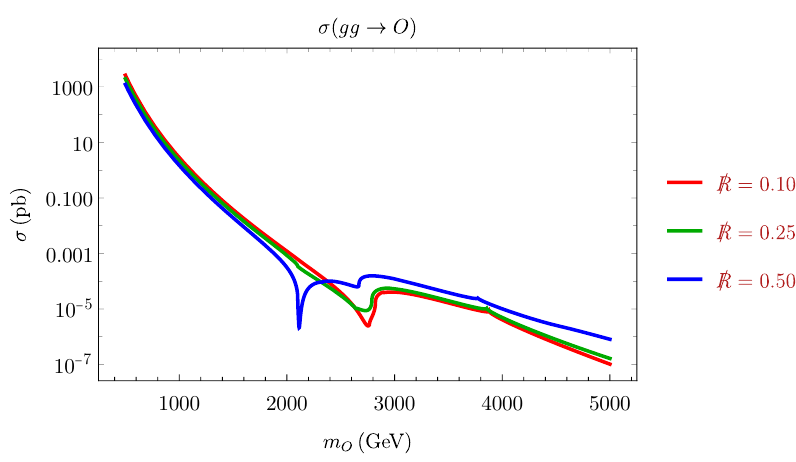
Figure 9. Cross sections of single scalar sgluon production by gluon fusion in Benchmarks